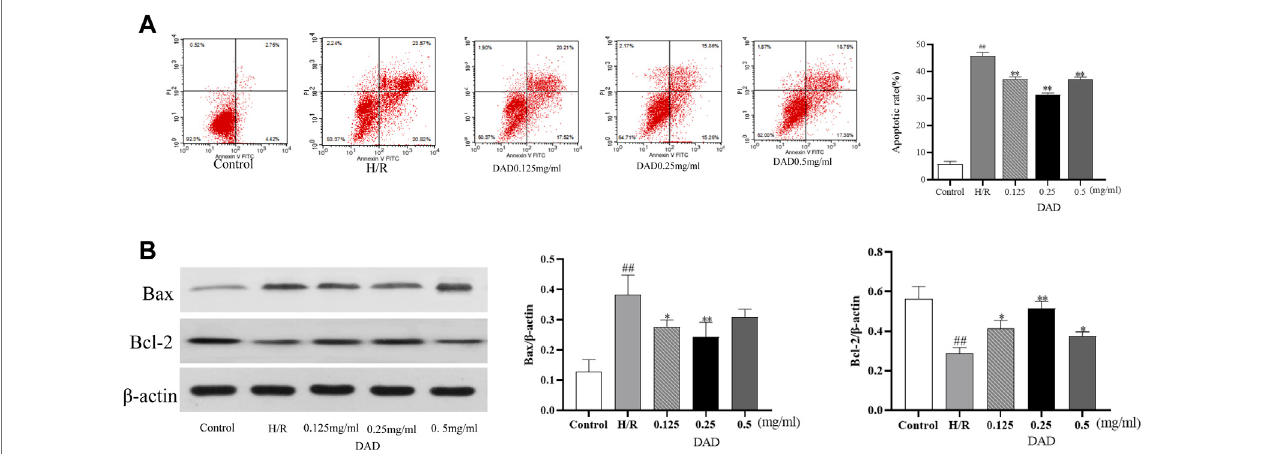
FIGURE4| Effects ofdried ginger-aconite decoction (DAD)on apoptosis rate and Bax/Bcl-2 expression ofH9C2 cellsafter H/R injury. (A) The effect on apoptosis rate. (B) The effect on the expression of Bax/Bcl-2. Data were presented as mean standard deviation (SD) of three independent experiments. #p < 0.05, ##p < 0.01 vs. control group. *p < 0.05, **p < 0.01 vs. H/R